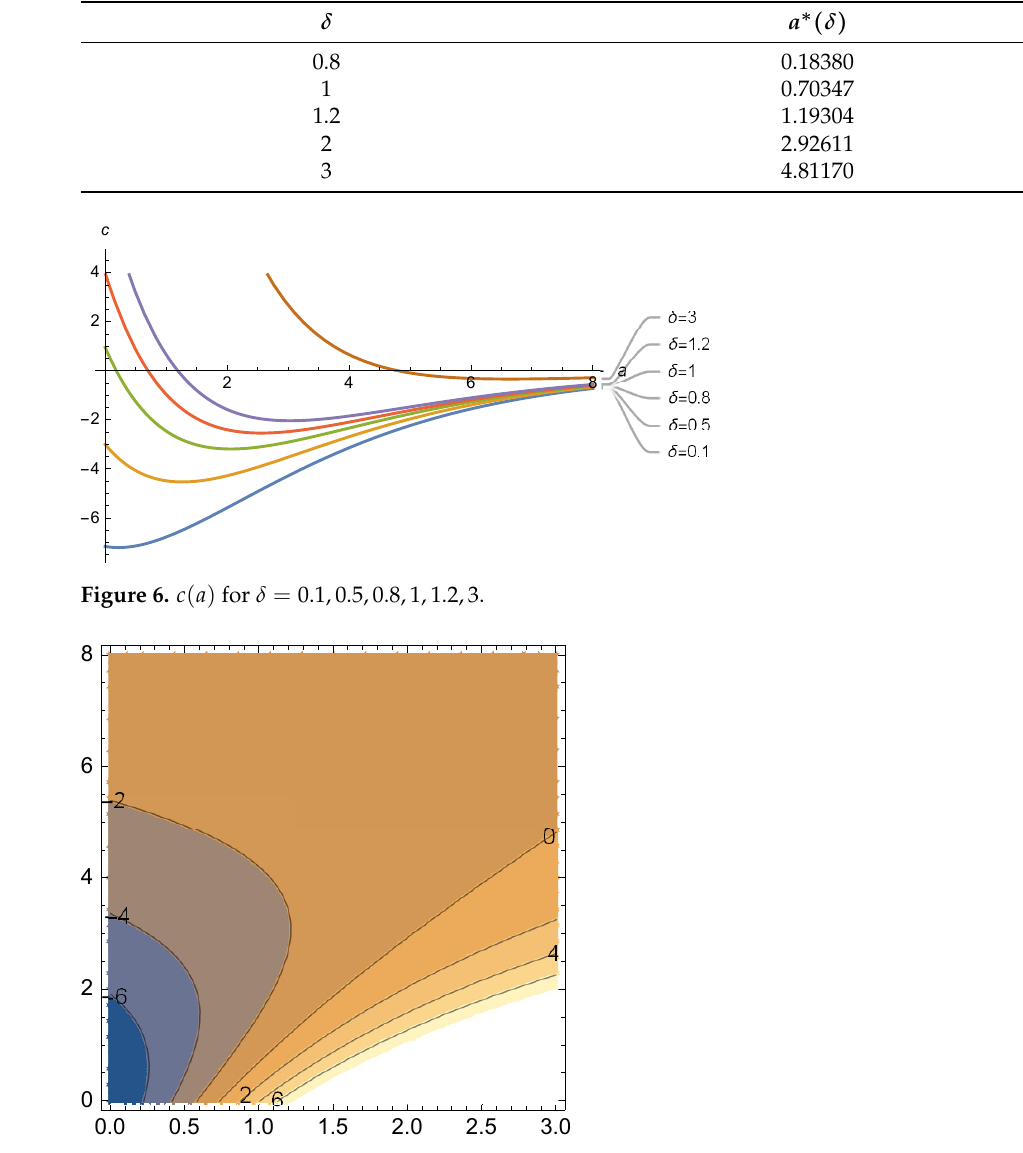
Figure 7. Contour plots of c ( δ , a )